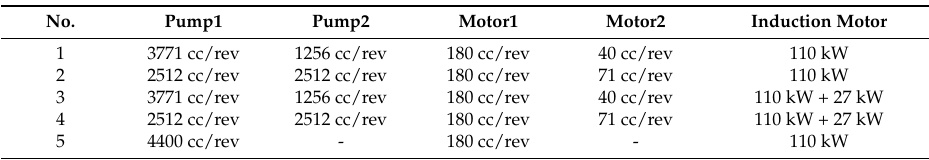
Figure 2. Wind turbine generator powertrain combinations. ( a ) Step 1–2: parallel hydraulic motor and serial induction motor; ( b ) Step 3–4: parallel hydraulic motor and parallel induction motor; and ( c ) Step 5: large-capacity pump and large-capacity hydraulic motor. Table 1. Wind turbine powertrain combination.